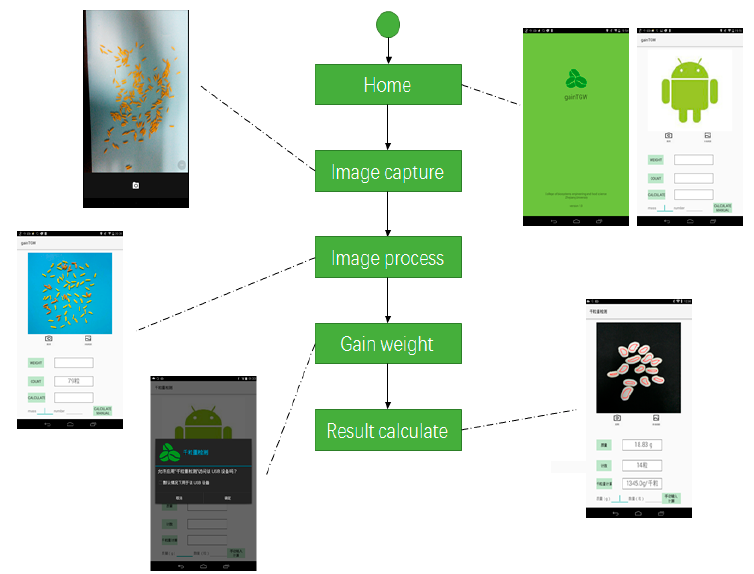
Figure 7. The flow-chart diagram of the “gainTKW” application illustrated with the application’s screenshots.